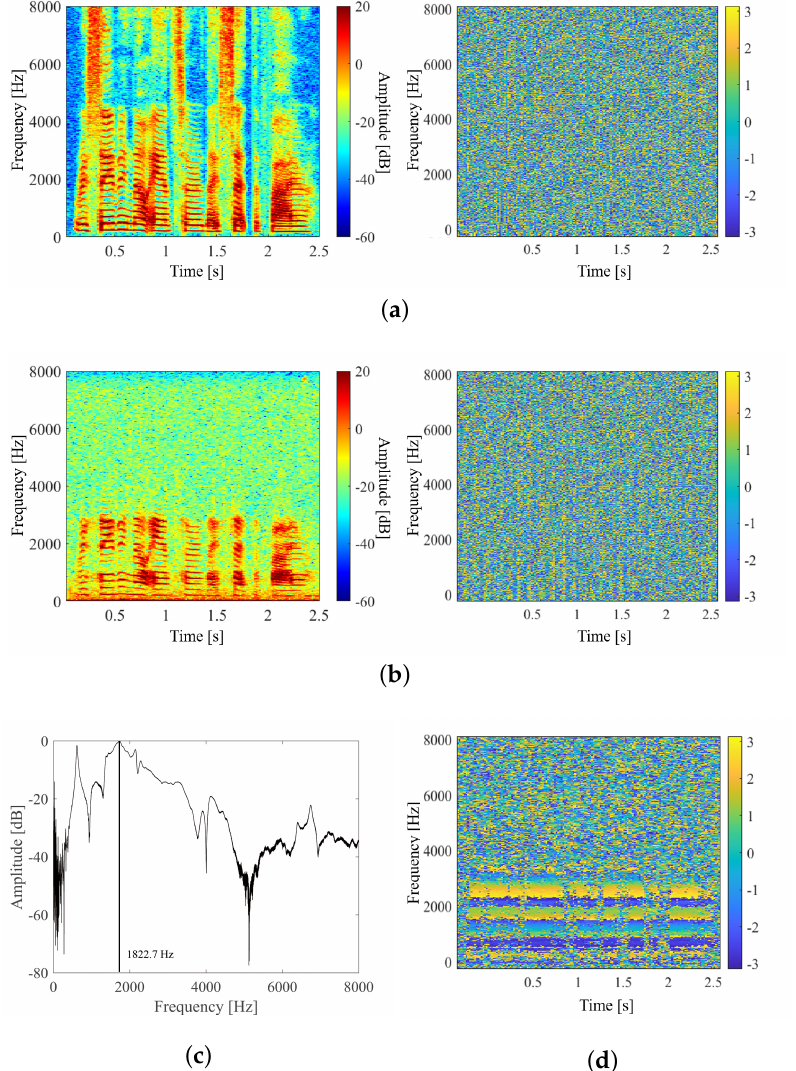
Figure 2. Power and phase spectrum of clean speech and observed speech and phase difference. ( a ) Power spectrum of clean speech ( left ) and its phase spectrum ( right ). ( b ) Power spectrum of observed speech ( left ) and its phase spectrum ( right ). ( c , d ) Amplitude response and phase difference between ( a , b ),